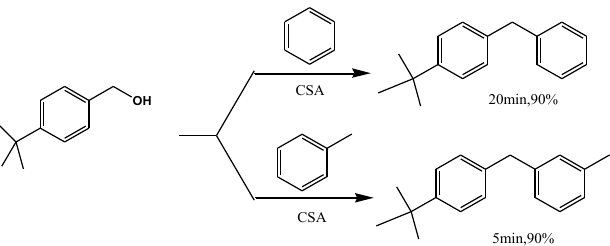
Figure 6. The mechanism of alcohols Friedel-Crafts alkylation reaction with benzene in the presence of supported cellulose sulfonic acid on silica gel.